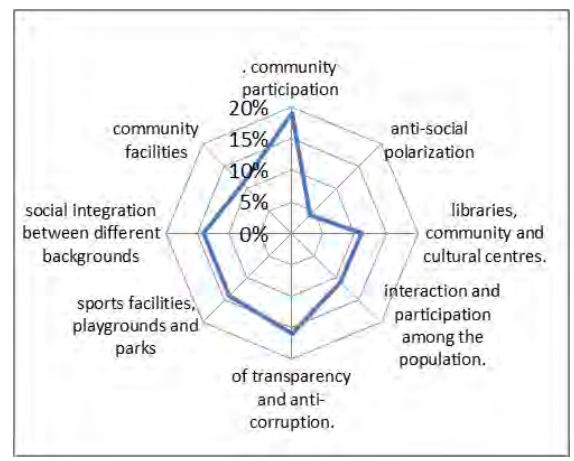
Figure 7. Support community participation and interaction among residents